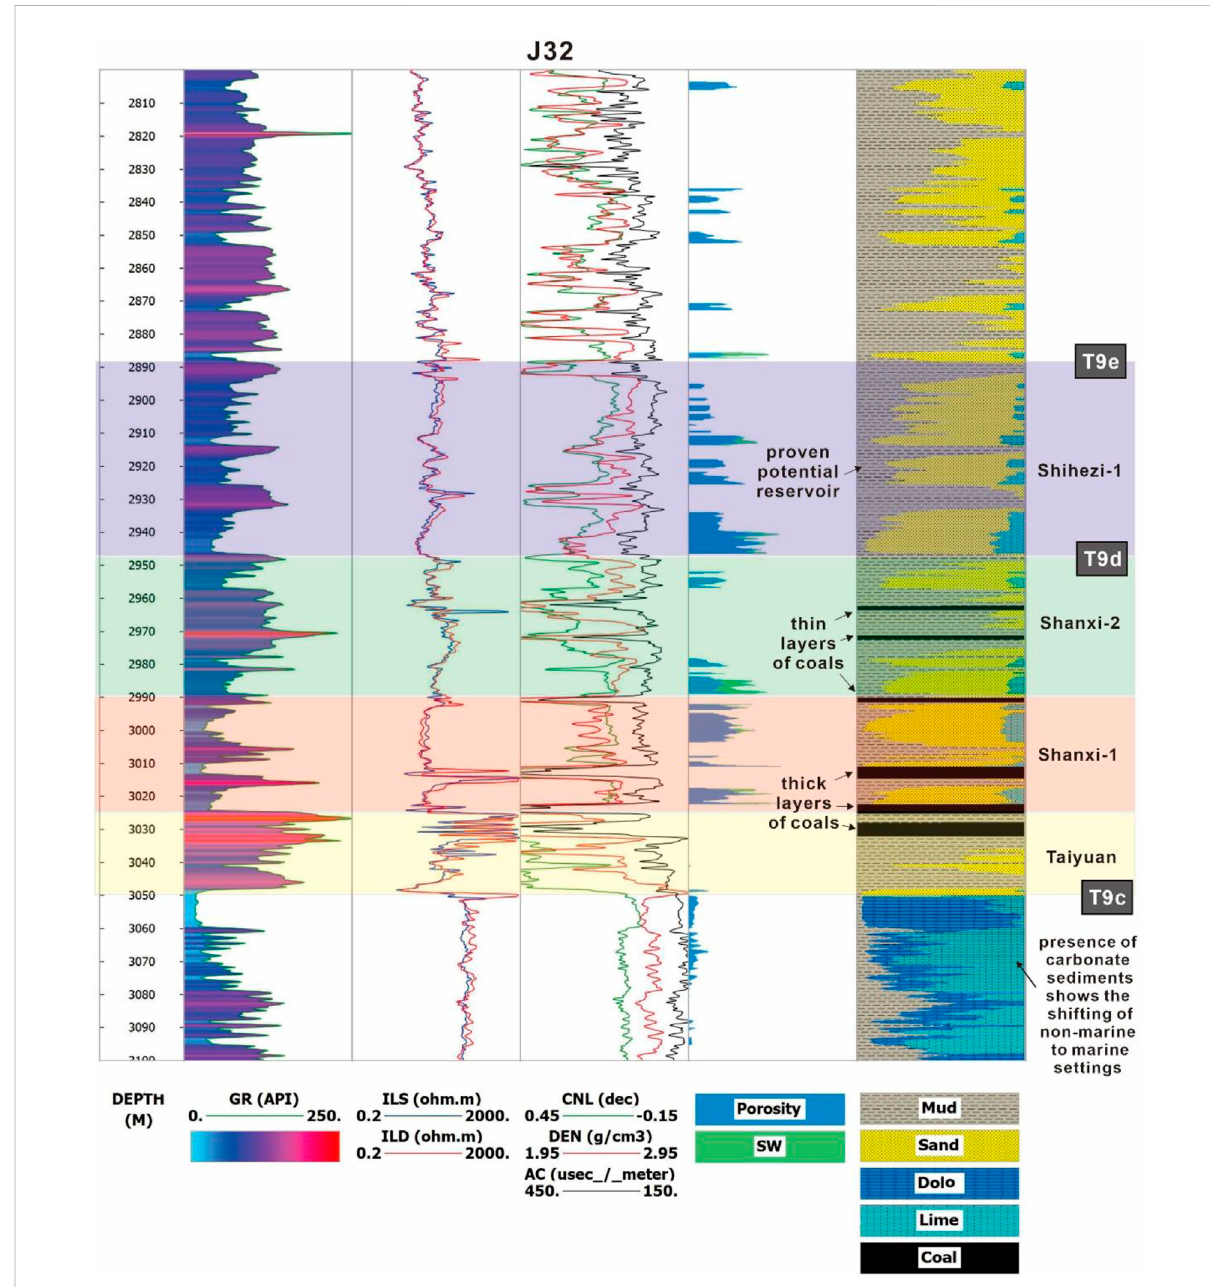
FIGURE 2 Petrophysical analysis of J32. The highlighted zones show the targeted zone of interest (ZOI). Shihezi-1 formation is a proven reservoir and mostly consists of sand and mud facies. Whereas, Shanxi-2 and Shanxi-shows coal layers, but also shows prominent porous zones. The Taiyuan formation zoneshows athickcoallayerandprominentmudfacies.TheareabelowtheZOIshowsfrequentcarbonate facies highlighting themarine depositional